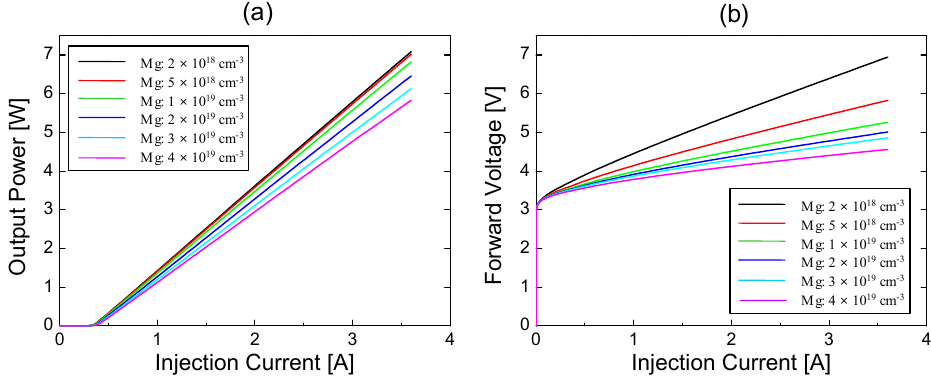
Figure 9. ( a ) L–I and ( b ) V–I curves for various Mg-doping concentrations from 2 × 10 18 to 4 × 10 19 cm − 3 in the p-cladding layer.